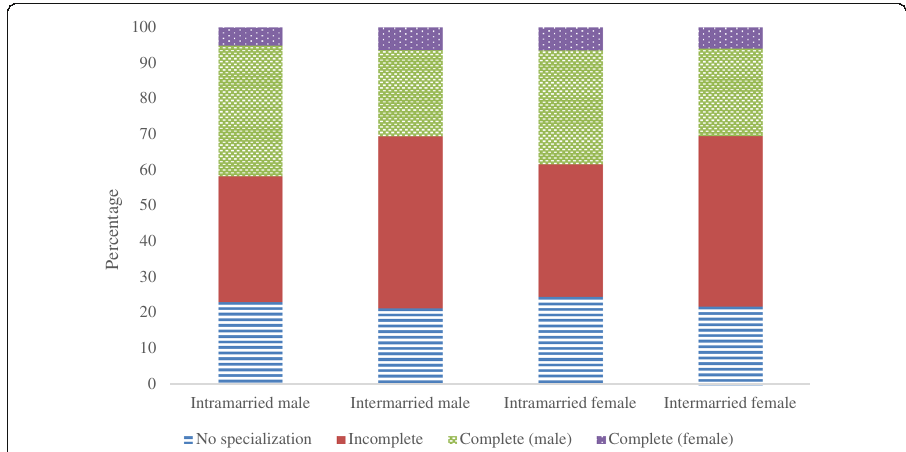
Fig. 1 Household specialization of immigrant households: by type of marriage and immigrant